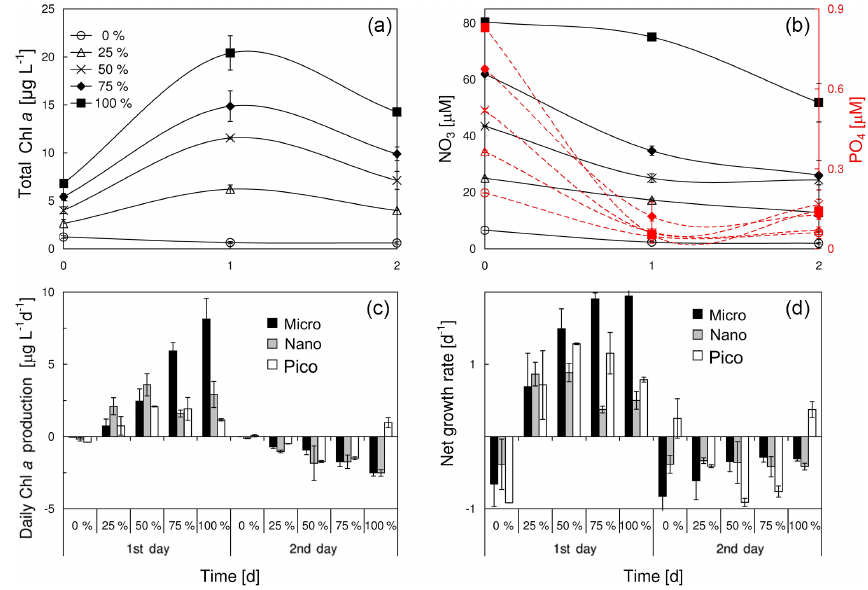
Figure 7. Responses of (a) total chlorophyll a , (b) nitrate and phosphate, (c) size-fractionated rate of daily chlorophyll a production and (d) size-fractionated net growth rate of the surface water at S4 to a varying percentage of plume water from S2. The experiment was started on 19 June